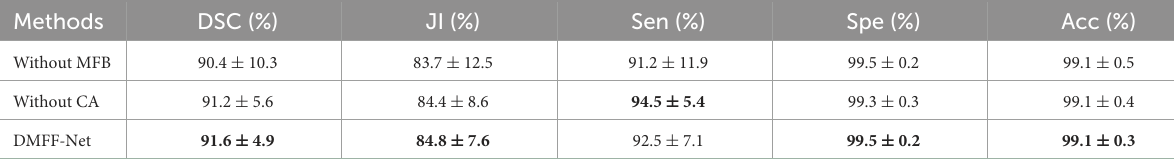
TABLE 5 Impact of multiscale feature fusion block and coordinate attention on network performance.